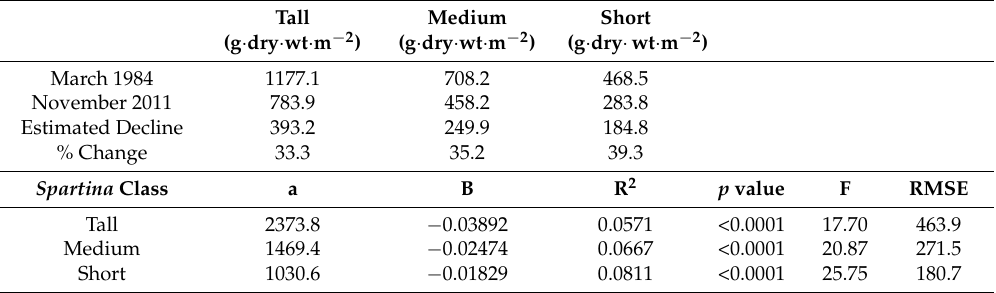
Figure 6. Extracted biomass values from Landsat 5 data for three height classes of S. alterniflora ( A ) tall; ( B ) medium; and ( C ) short size classes over the 28 year study period. Gray line corresponds to day-of-year look up table values calculated by interpolation of the binned monthly biomass estimates in Figure 5. Regression equations and coefficient of determination for ( A ) y = 2373.84 − 0.0389x; 0.057; ( B ) y = 1469.35 − 0.0247x; 0.067; and ( C ) y = 1030.64 − 0.0183x; 0.081. Also shown are mean monthly values for ( D ) Altamaha River Discharge at Doctortown, GA and ( E ) Palmer Drought Severity Index for region 9 in Georgia (Figure 4). Table 4. Results of fitting a simple linear regression line for the 28-year period of observation for biomass estimates of the three size classes of S. alterniflora ( n = 294; see Figure